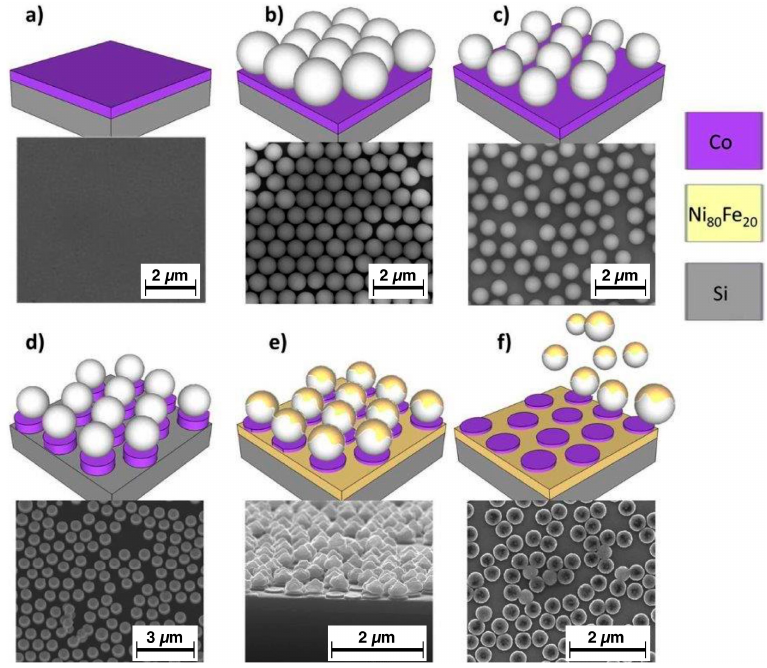
Figure 1. (Colour online) Scheme of the preparation process of Co dots and Ni 80 Fe 20 antidot arrays constituting bi-component nanostructured systems, by polystyrene nanospheres lithography. ( a ) Initial continuous Co layer. ( b ) Polystyrene nanospheres self assembly. ( c ) Nanospheres diameter reduction. ( d ) Excess Co removal by Ar + etching. ( e ) Ni 80 Fe 20 deposition. ( f ) Nanospheres removal, final bicomponent structure.